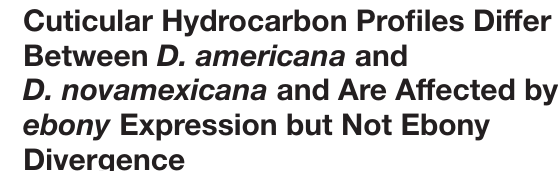
FIGURE 5 | Cuticular hydrocarbons (CHCs) are affected by ebony and differ between D. americana and D. novamexicana . (A–C) Abundance of individual CHC compounds (ng/fly) and summed CHCs extracted from female flies are plotted for the following genotypes: (A) D. americana and D. novamexicana , each heterozygous for an ebony null ( e - ) allele, (B) D. americana heterozygous and homozygous for an ebony null allele, (C) D. novamexicana heterozygous and homozygous for an ebony null allele. Eight biological replicates are shown for each genotype, with error bars representing 95% confidence intervals. For each comparison, the p -value from a Welch’s t -test with a Benjamini–Hochberg multiple test correction ( alpha = 0.05) is shown when a significant difference in abundance was detected for a CHC present in both genotypes being compared. CHCs are shown from left to right with increasing chain length (represented by “C” followed by the chain length) with double-bond and methyl-branched structures indicated by notations after the colon or before the “C”, respectively. For example, C25:1 represents a 25-carbon monoene, C25:2 represents a 25-carbon diene, and 2Me-C28 represents a 28-carbon alkene with a methyl branch at the second carbon. (D–E) Abundance of each CHC in ebony null mutants relative to flies heterozygous for the ebony null allele is plotted by carbon chain length for (D) D. americana and (E) D. novamexicana . Black trendlines in panels ( D–E) show linear regressions, with shaded areas representing the standard error and both Spearman’s rho and p -values indicated on each